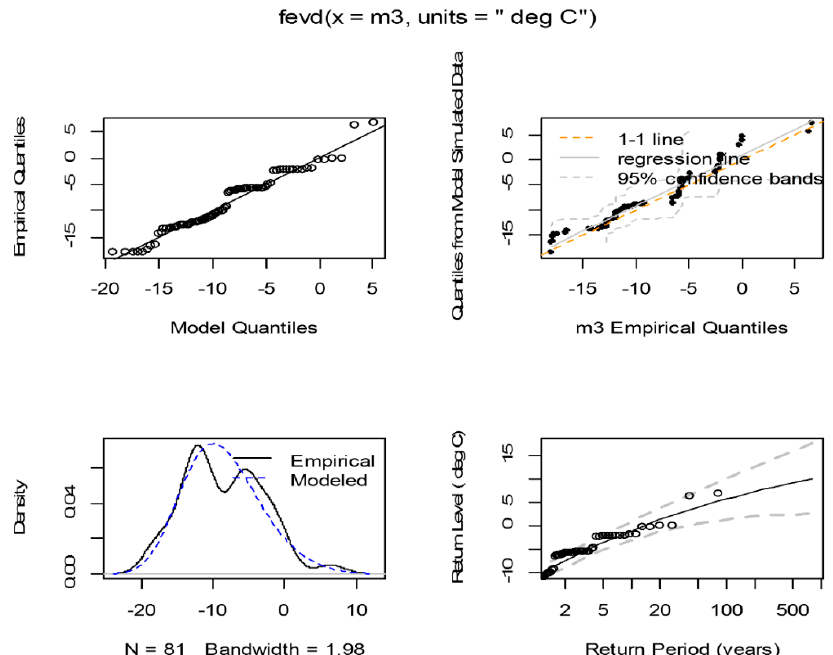
Figure 6. Diagnostic annual minimum temperature plots.